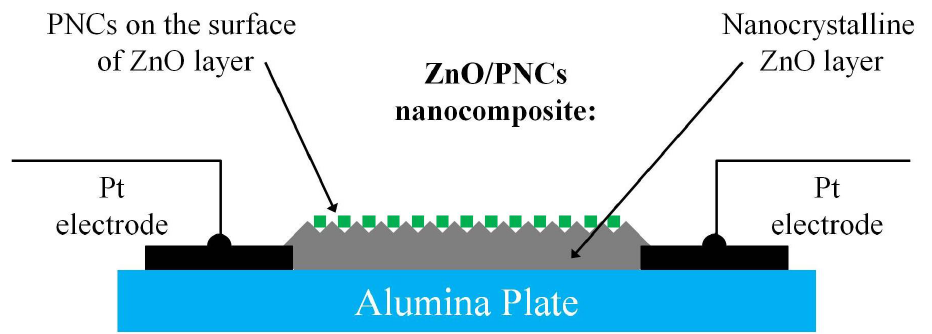
Figure 1. Schematic representation of the structure of a ZnO/PNCs photosensitive element, including alumina plates with Pt contacts, a nanocrystalline ZnO thick layer, and PNCs covering the top of ZnO layer.